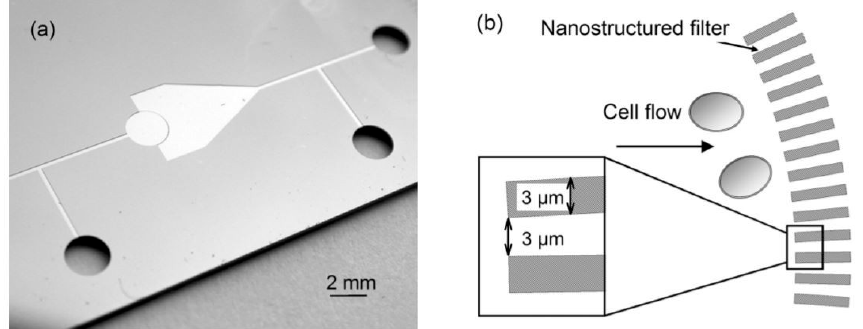
Figure 9. ( a ) The nanostructured mechanical filter utilized in [38]. ( b ) A schematic of the mechani- cal lysis portion of the device Adapted with permission from [38]. Copyright 2003 Royal Society of Chemistry.